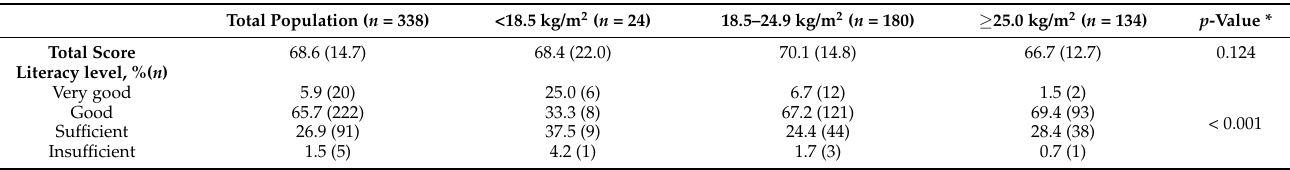
Table 5. The literacy level of the population studied according to BMI